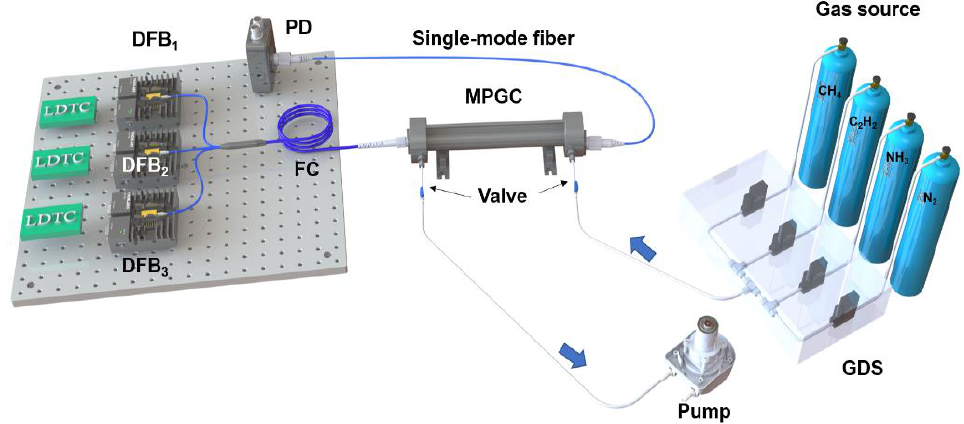
Figure 3. Schematic of the laser-based multipass absorption sensor. DFB, distributed feedback laser; LDTC, laser driver and temperature controller; PD, photodetector; FC, fiber coupler; MPGC, multipass gas cell; GDS, gas dilution system.